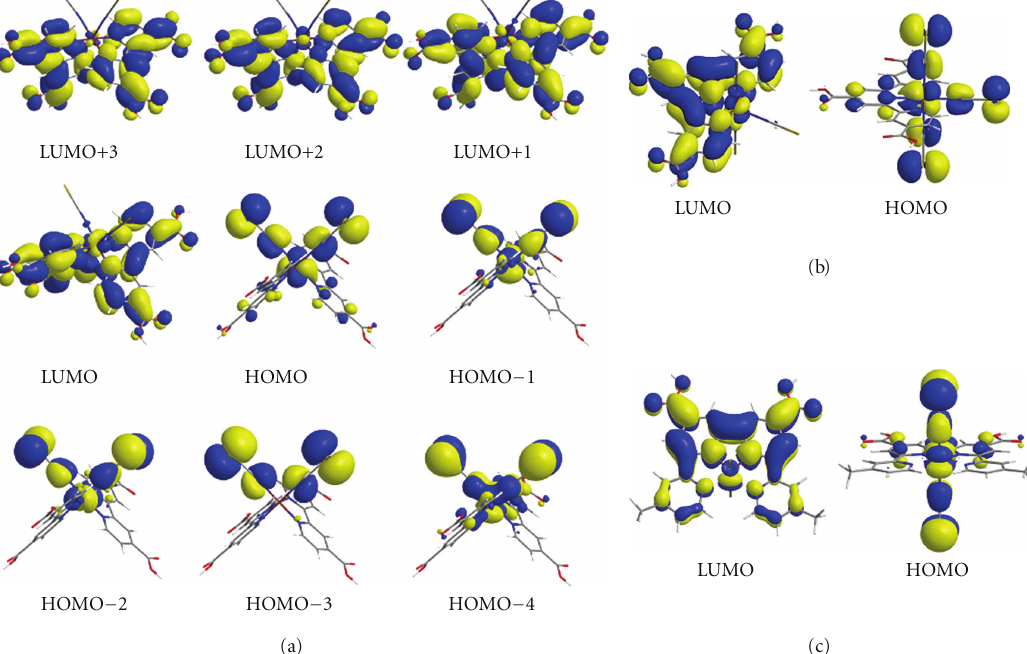
Figure 4: Selected frontier molecular orbitals of the complexes 1 (a), 4 (b), and 6 (c) calculated at the B3LYP/6-31G ∗ level in MeCN solution. Isodensity contour: